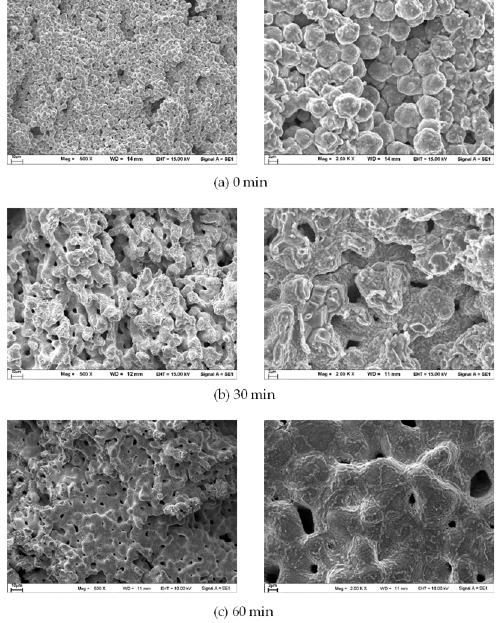
Figure 10. SEM images of sintered micro-copper clay with different heating times at ( a ) 0 min, ( b ) 30 min, and ( c ) 60 min. ( b ) 30 min, and ( c ) 60 min.